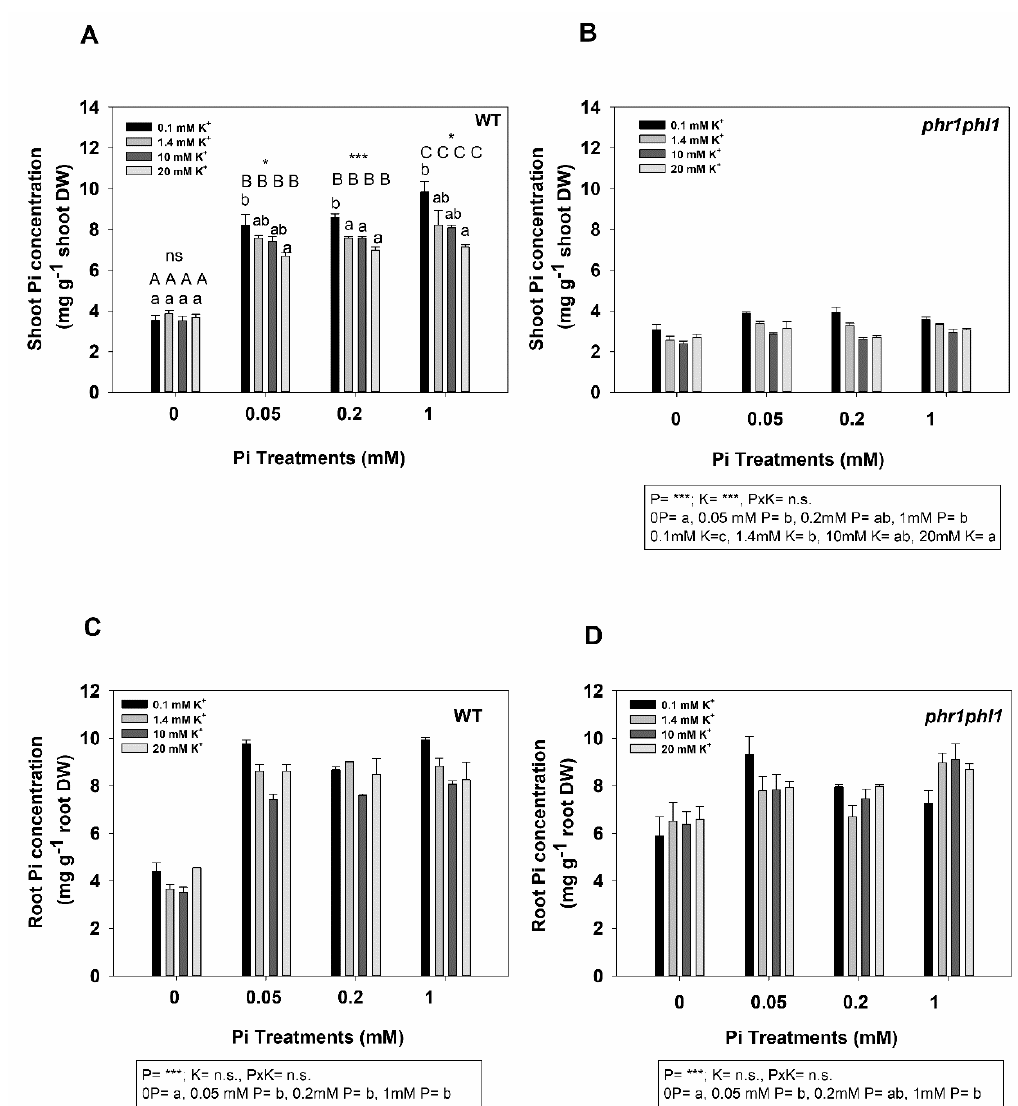
Figure 3. Shoot and root Pi concentrations of plants exposed to di ff erent K + and Pi concentrations. Plants of WT and phr1phl1 mutant were grown for 33 days in a control 1 / 5 Hoagland solution and the transferred for 7 days to solutions with 0, 0.05, 0.2, or 1 mM Pi and 0.1, 1.4, 10, and 20 mM KCl. After these treatments WT shoots ( A ) and roots ( C ) and phr1phl1 shoots ( B ) and roots ( D ) were collected, dried, acid digested and their P concentrations determined by ICP spectrometry analysis. Shown are average P concentrations of three repetitions and errors bars denoted standard error. ANOVA was used to study the e ff ects of the Pi treatment (P), the K treatment (K), and their interaction (PxK), resulting in: ( A ) P = ***, K = *** and PxK = *. Bars with di ff erent letters within each treatment denote significant di ff erences according to Tukey test (uppercase letters for P treatments and lowercase letters for K treatments). Di ff erences between K treatments within each P treatment were analyzed according to ANOVA. *** and * indicate significant di ff erences at p < 0.001 and 0.05 respectively. n.s. indicates non-significant at p > 0.05. For ( B ), ( C ) and ( D ) ANOVA and Tukey tests results are indicated below the corresponding